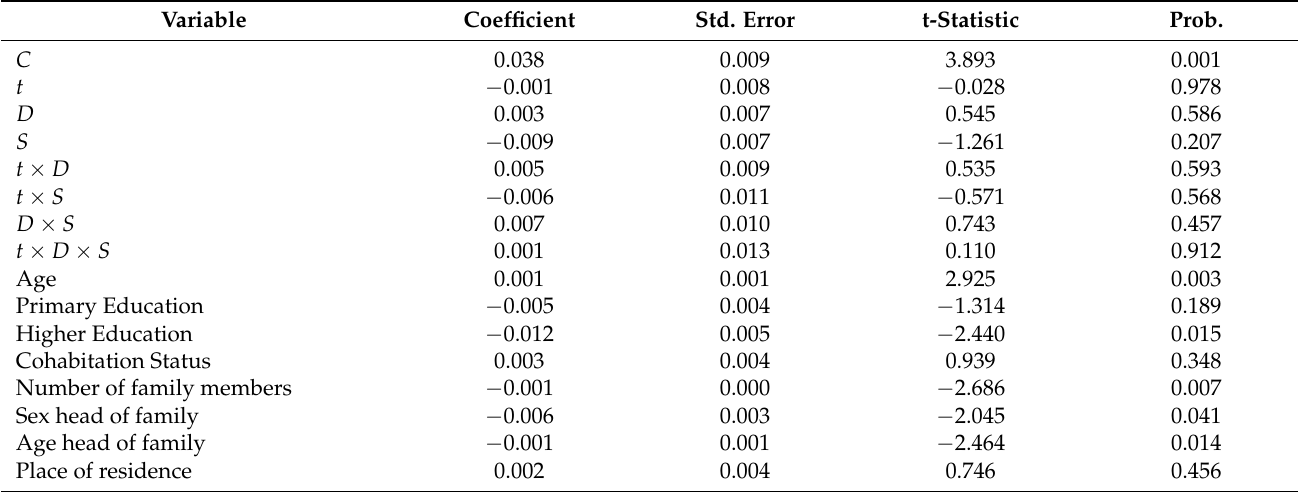
Table 4. The validation of parallel trends with the placebo test control group.